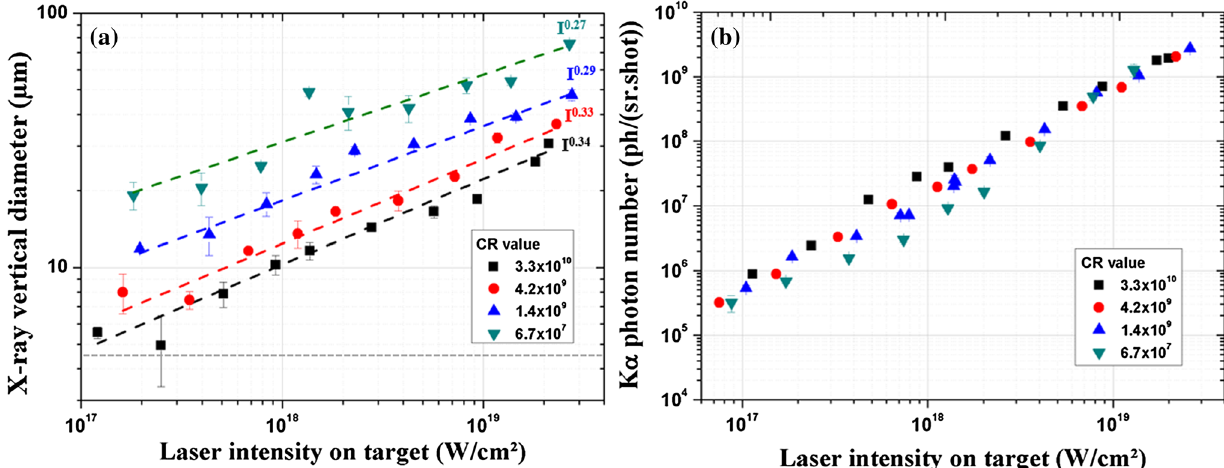
Figure 1. (a) FWHM x-ray vertical diameter versus laser intensity on target, for four temporal contrast ratio values. The error bars correspond to the standard deviation of the average FWHM line spread function measured for three different zones of the knife edge image. The dashed lines for the x-ray source diameter data correspond to a I ε power fit with ε varying with the contrast ratio value. The grey horizontal dashed line represents the FWHM vertical laser focal diameter (~ 4.6 µm). (b) K α photon number versus laser intensity on target, for four temporal contrast ratio values. The error bars are given by the standard deviation calculated from three independent measurements of N Kα